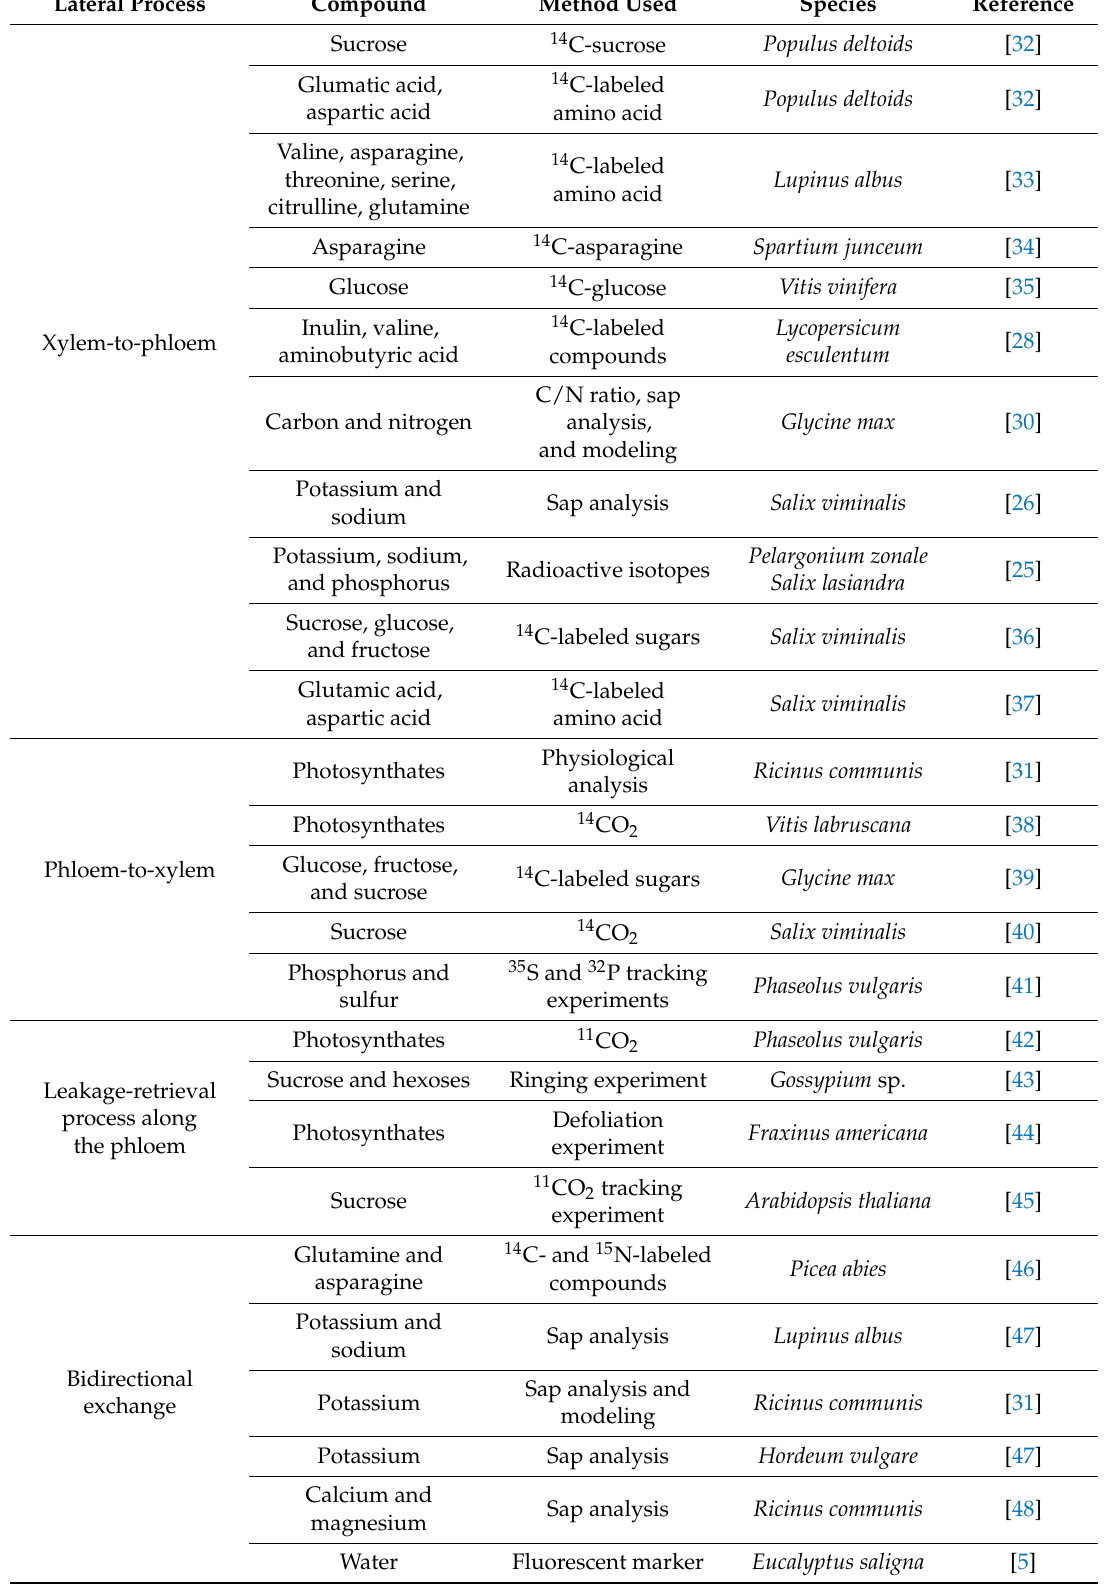
Table 1. Experimental evidence for lateral transport of solutes in angiosperms and